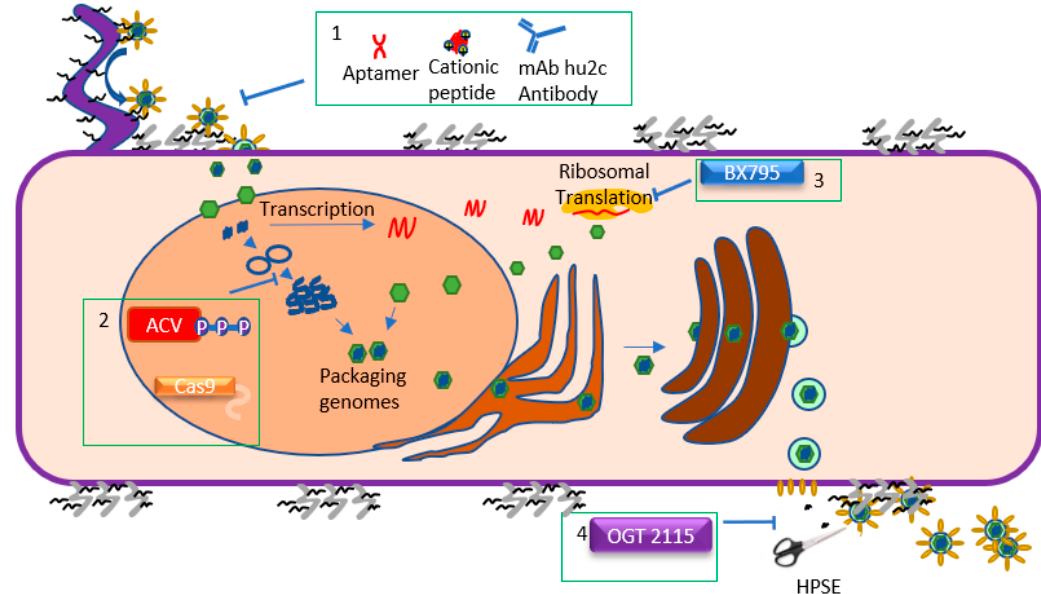
Figure 2. Schematics of the HSV-1 lifecycle and the steps targeted by antiviral agents. HSV-1 begins the entry process by attaching to heparan sulfate (HS) moieties located on proteoglycans on the cell surface. HSV-1 can also attach to HS chains on filopodia and engage in “viral surfing” along the filopodia to the cell surface. Once the HSV-1 glycoproteins have attached to their appropriate receptors, the viral envelope fuses with the host cell membrane, releasing the tegument and nucleocapsid into the cytoplasm. Viral entry can be inhibited ( Box 1 ). Once in the cell, the capsid travels to the nucleus and injects the viral genome into it. HSV-1 then undergoes a process of circularizing, concatemerization, and packaging its genome into new capsids. During this period, the virus also transcribes mRNA and translates it, creating new proteins. Acyclovir and CRISPR/Cas9 inhibit vDNA replication, while BX795 impedes viral translation ( Boxes 2 and 3 , respectively).